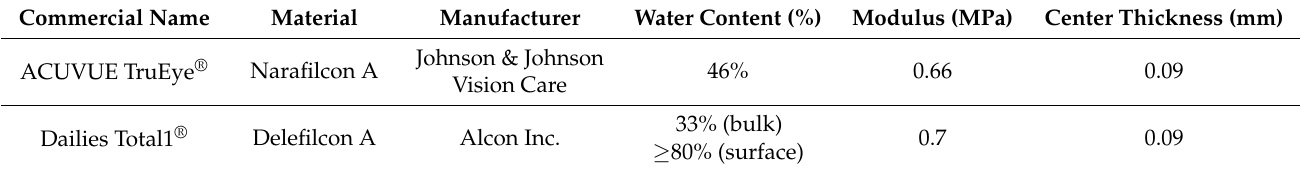
Table 1. List of silicone hydrogel commercial contact lenses that are used in the present